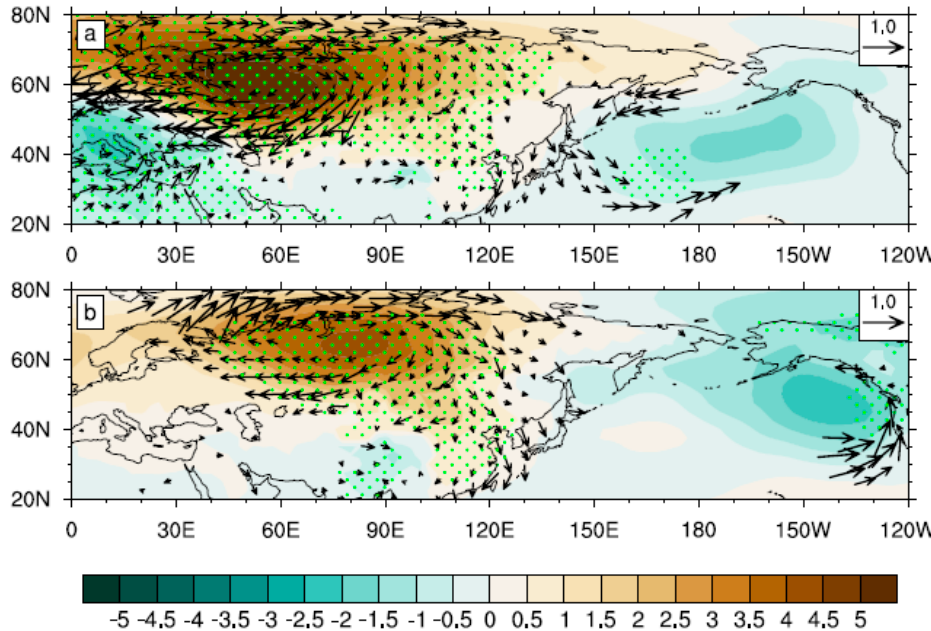
Figure 3. Regression of 10 m winds (vectors, exceeding the 95% significance level based on the two- sided Student’s t -test, unit: m/s) and SLP (shading, hPa) anomalies in JFM onto the normalized JFM SH index during ( a ) 1980–2002 and ( b ) 2003–2020. The green dots denote the significant SLP anom- alies above the 95% confidence level based on the two-sided Student’s t-test.